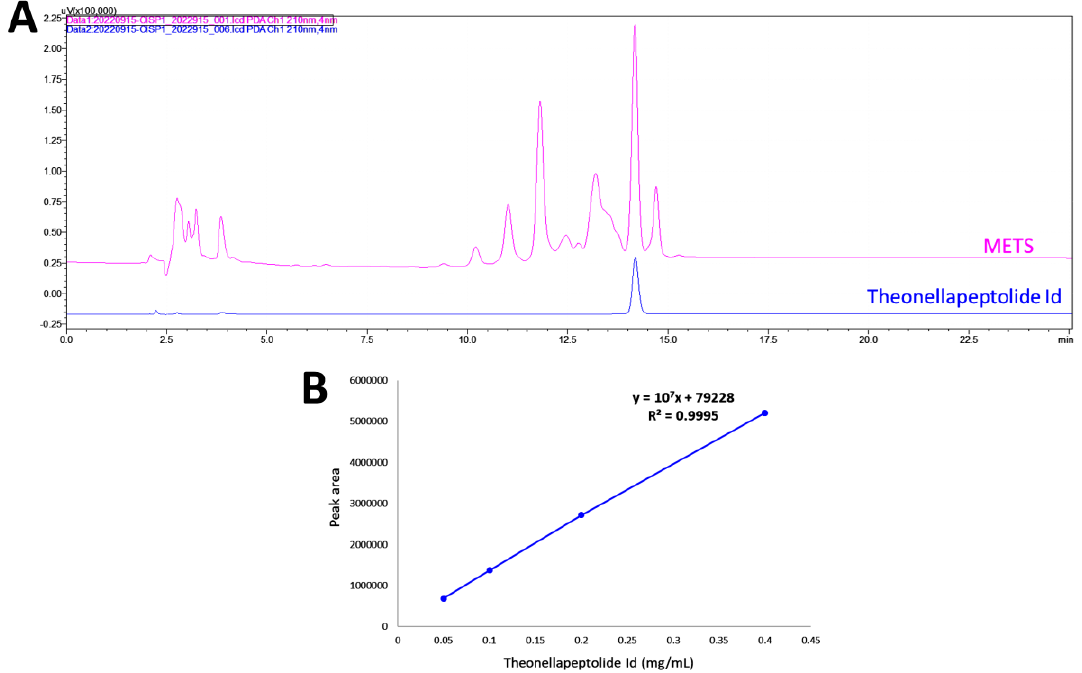
Figure 1. Fingerprint profile. ( A ) Fingerprint profiles of METS (pink, upper line) and the theonella- peptolide 1d (blue, lower line). ( B ) The calibration curve of theonellapeptolide 1d ( n = 3).